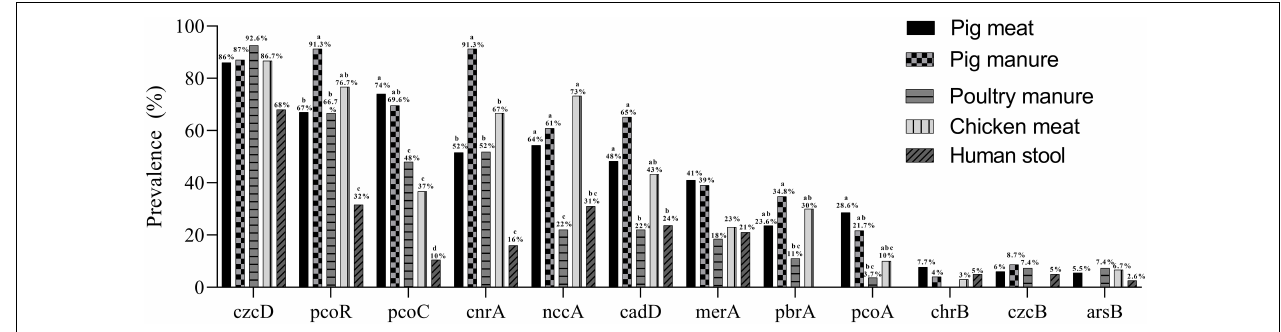
FIGURE 3 | Prevalence of heavy metal resistance genes among Salmonella Typhimurium isolates from pig meat, pig manure, poultry manure, chicken meat, and human stool. Different lowercase letters indicate statistically significant differences between groups ( P < 0.05).